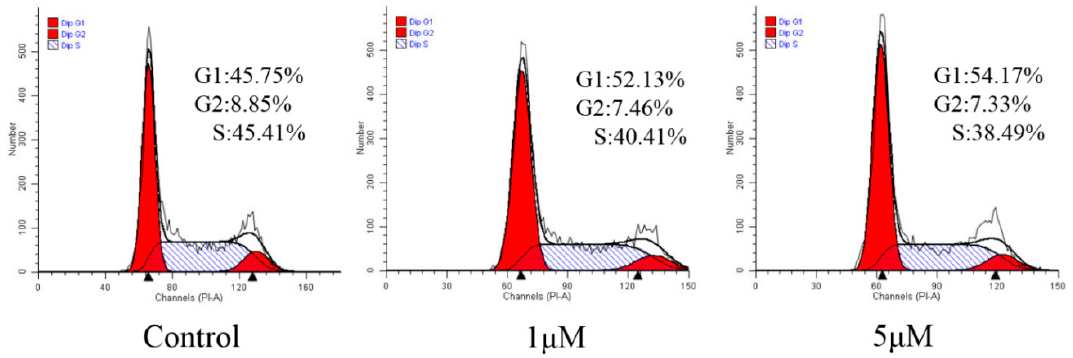
Figure 1. Effect of compound 4j on the cell cycle of human gastric MGC-803 cells.